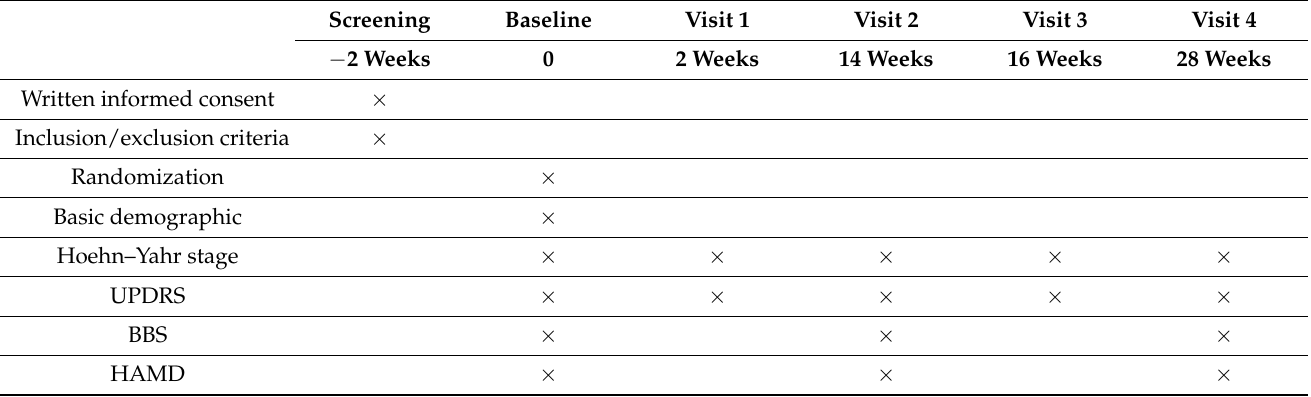
Figure 2. The NET-PD study flowchart. Table 1. Outline and timelines of the trial.